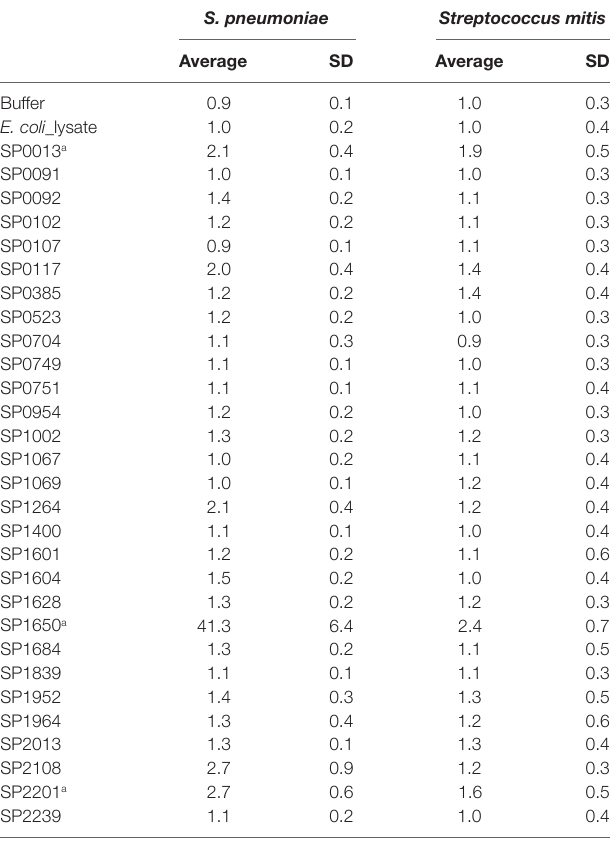
TaBle 2 | Quantification of fluorescence signal ratio of on-chip purified Streptococcus pneumoniae proteins obtained by ratio of fluorescence intensity of spot to fluorescence intensity of E. coli